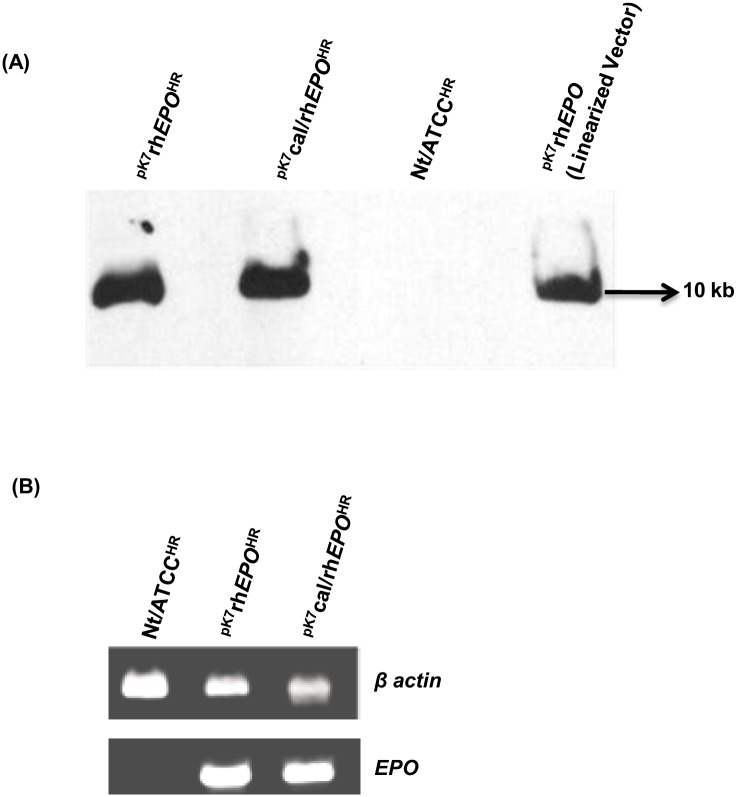
Genomic DNA and transcript analysis of hairy root cultures.(A) Southern blot analysis was performed using the genomic DNA of transformed hairy root clones. (B) RT-PCR analysis of EPO mRNA in hairy root cultures pK7cal/rhEPOHR and pK7rhEPOHR. The presence of mRNA for tobacco β actin gene is shown as an internal control for transcript analysis.